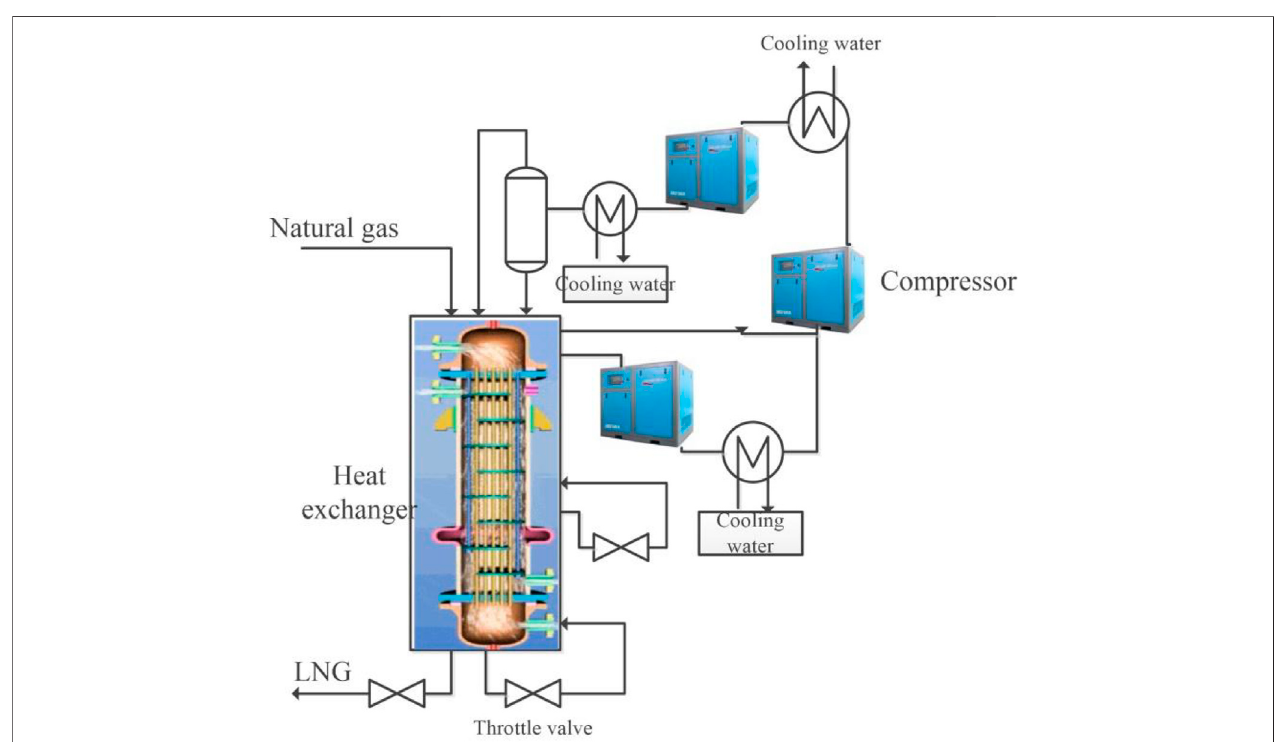
FIGURE 2 | Schematic diagram of liquefaction process after